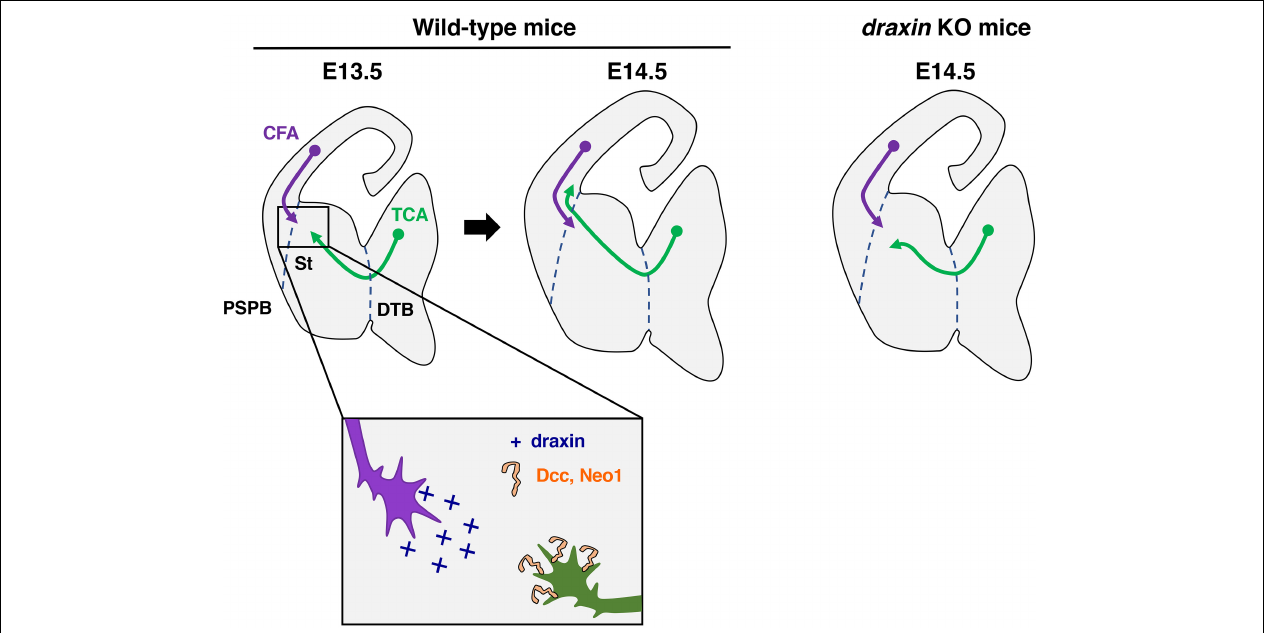
FIGURE 4 | Draxin signaling in the development of thalamocortical axons. Thalamocortical axons (TCA) and corticofugal axons (CFA) meet in the striatum (St) to form the internal capsule around E13.5. At E14.5, and TCA progress through the pallial-subpallial boundary (PSPB) to enter the neocortex in wild-type mice. In draxin KO mice, TCA do not cross the PSPB, while early CFA projected normally toward the internal capsule. We have proposed a model, in which draxin from CFA promotes the growth of TCA from the internal capsule to the neocortex, and this effect of draxin is mediated through the Dcc and Neo1 receptors. DTB, diencephalic/telencephalic